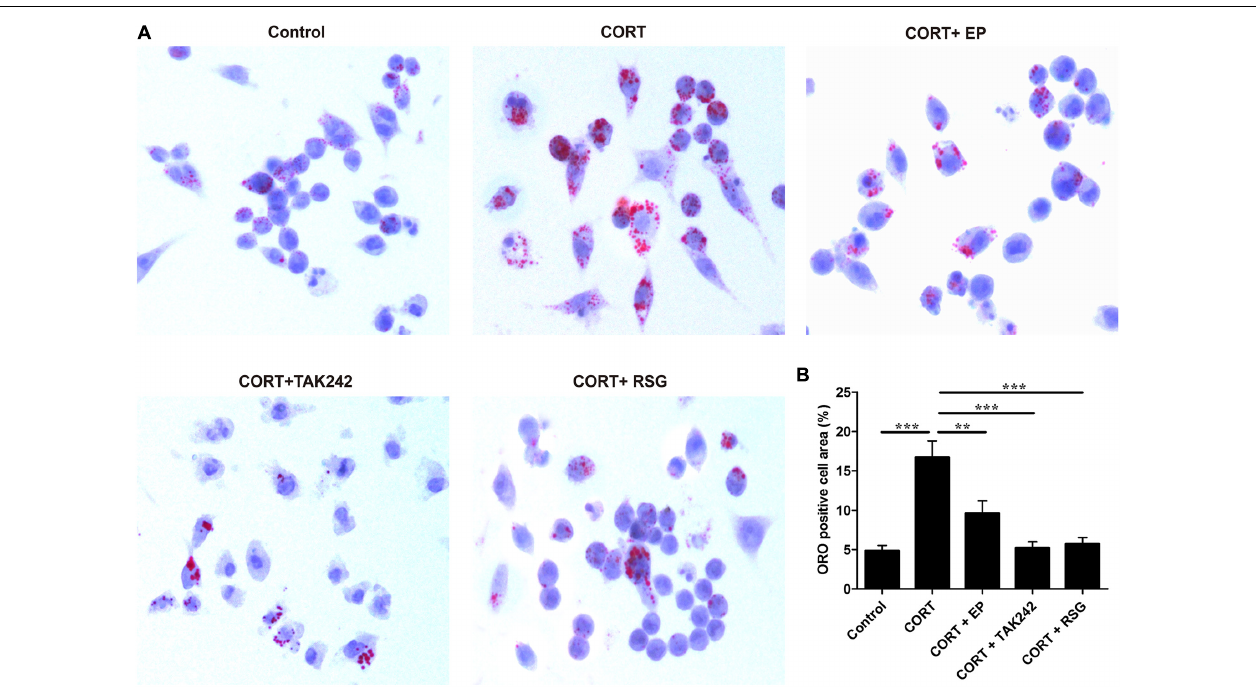
FIGURE 7 | Effect of EP, TAK-242, and RSG treatment on high level CORT-induced Raw 264.7 macrophage foam cell formation. Raw 264.7 macrophage cells were cultured ox-LDL (20 µ g/mL) with or without EP (5 mM), TAK-242 (1 µ M), and RSG (10 µ M), in present or absence of 5 µ M of CORT for 36 h. (A) Macrophages were fixed and stained with Oil Red O to evaluate foam cell formation (original magnification: 40 × ). (B) Quantification of Oil Red O (ORO) staining positive areas. Data were expressed as mean ± SEM ( n = 3). ∗∗ P < 0.01, ∗∗∗ P <